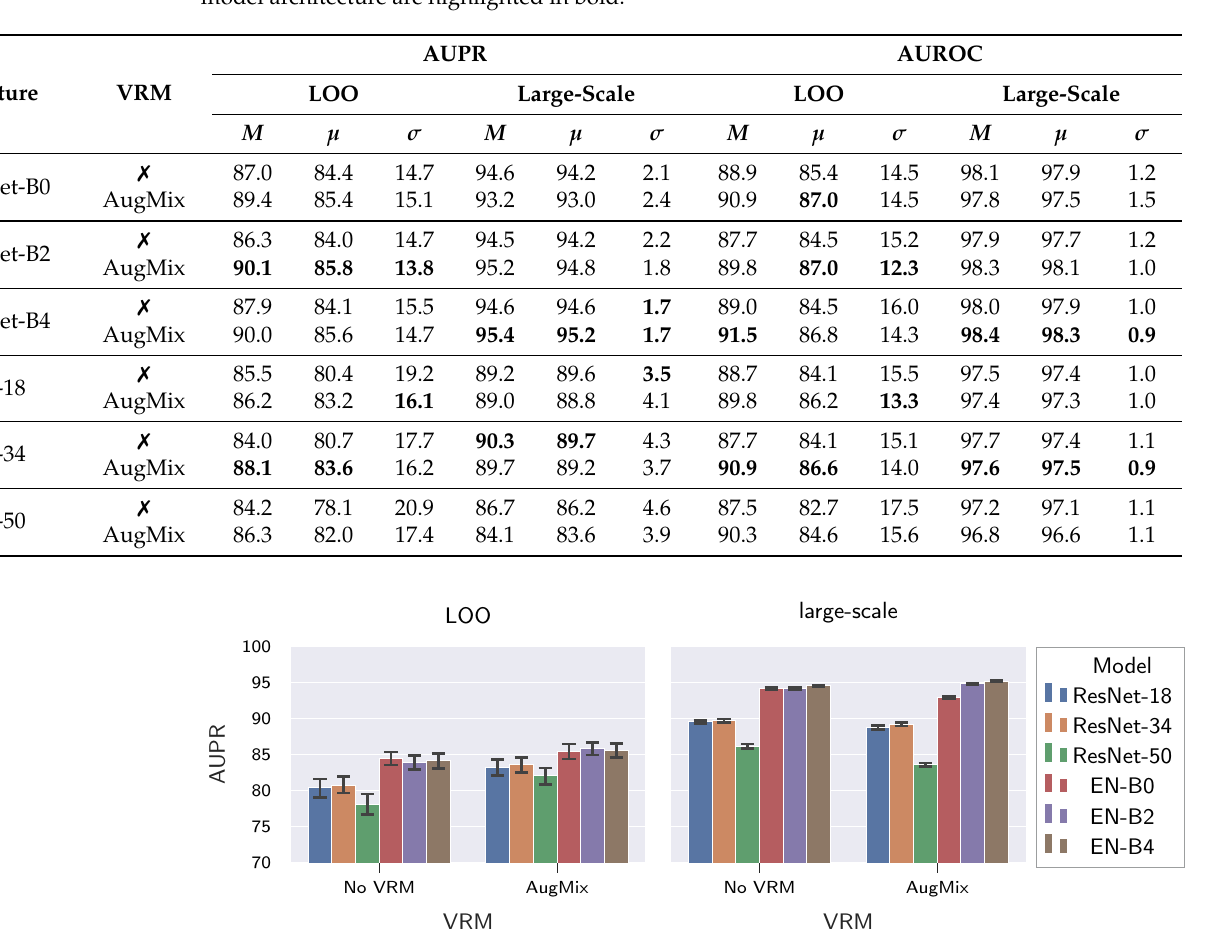
Figure 9. Influence of model architecture and complexity as well as AugMix on the generalization of supervised fabric AD methods. We show both the mean and 95% CI for the AUPR achieved on the held-out fabrics, as well as on the large-scale dataset by different ImageNet-pre-trained models that are fine-tuned with the HSC loss. Abbreviations: EN =